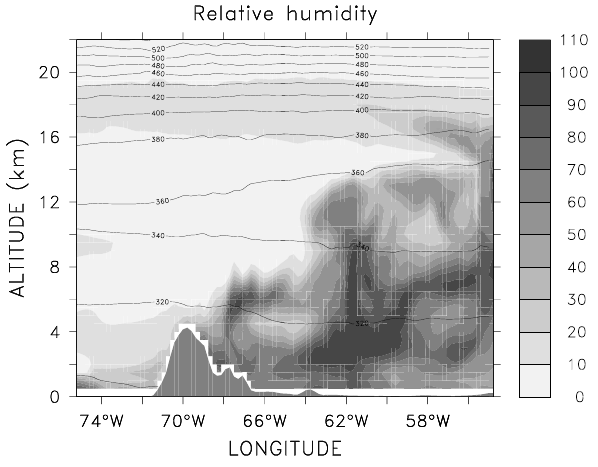
Fig. 13. Case 2: Results of the WRF simulations. Relative humid- ity. Longitude-altitude cross section at latitude −